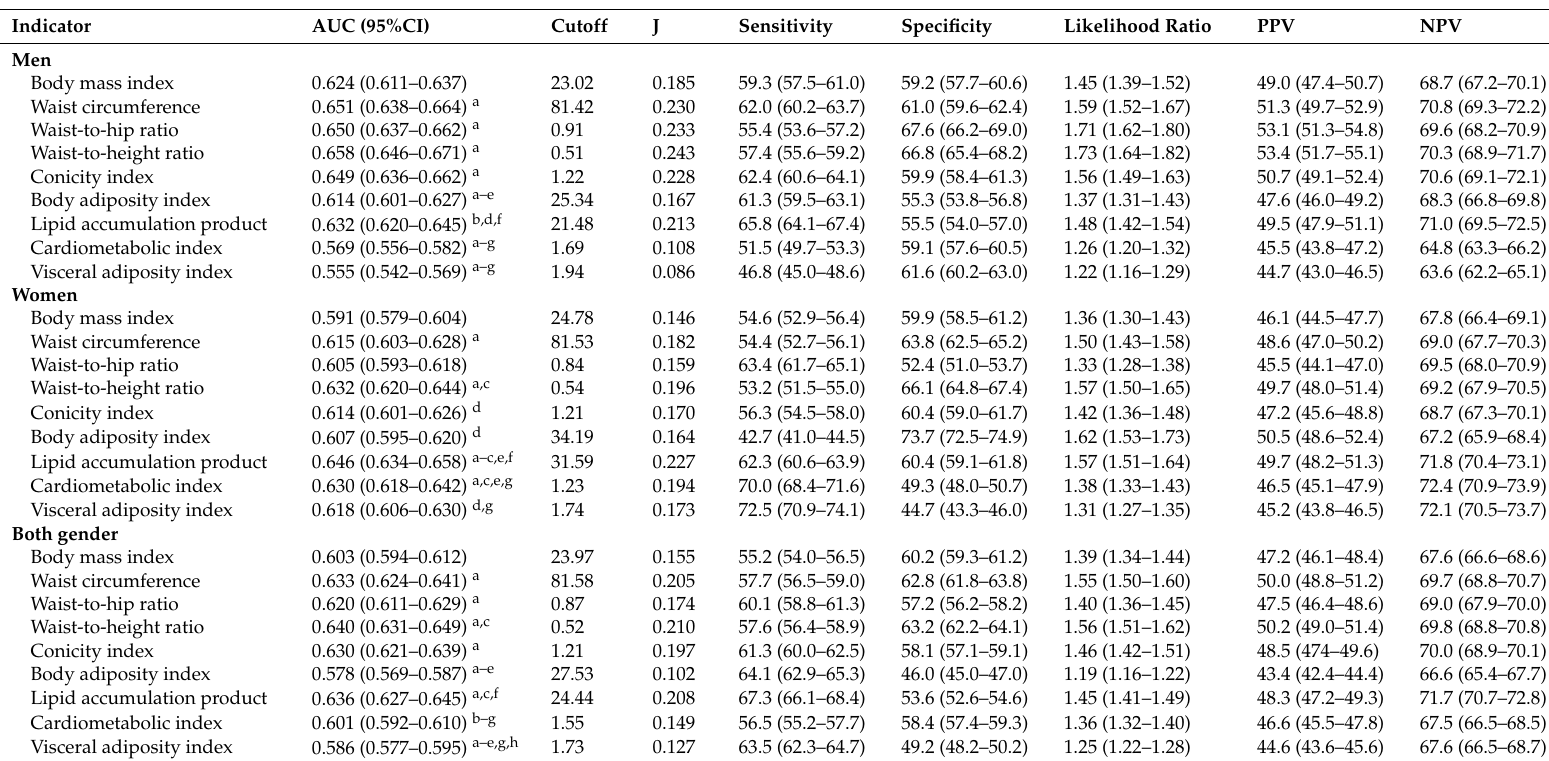
Table 2. Area under curve (AUC), cut-off point and diagnostic performance of various anthropometric and adiposity indices with hypertension classified by gender.